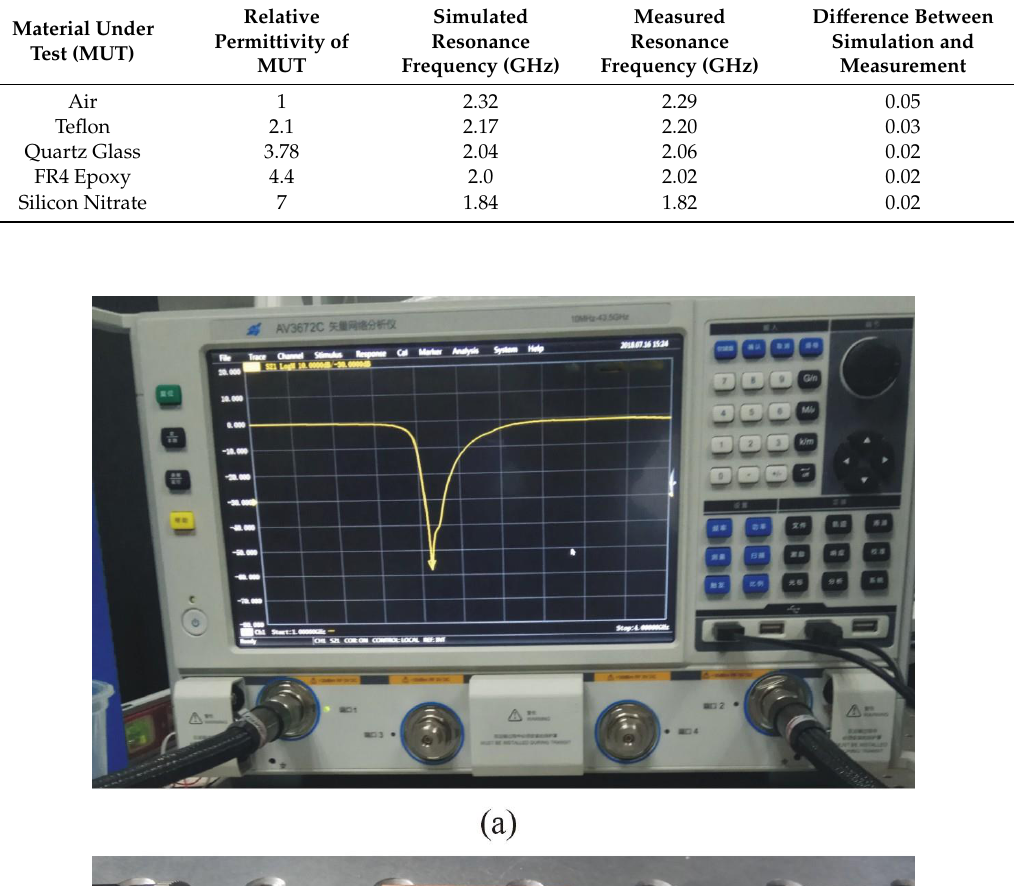
Table 3. Simulated and measured results of sensor for different MUTs.